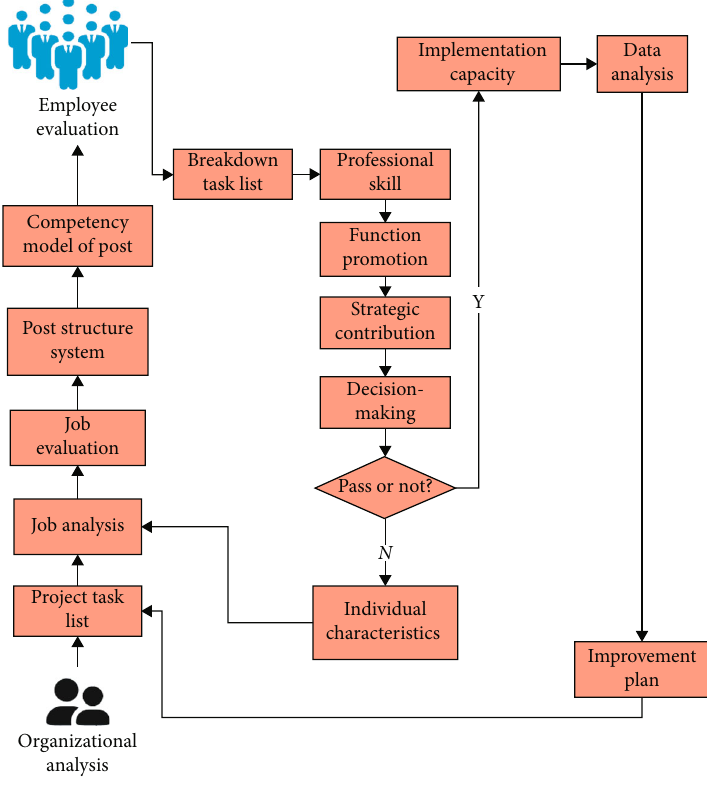
Figure 2: Post competency quality